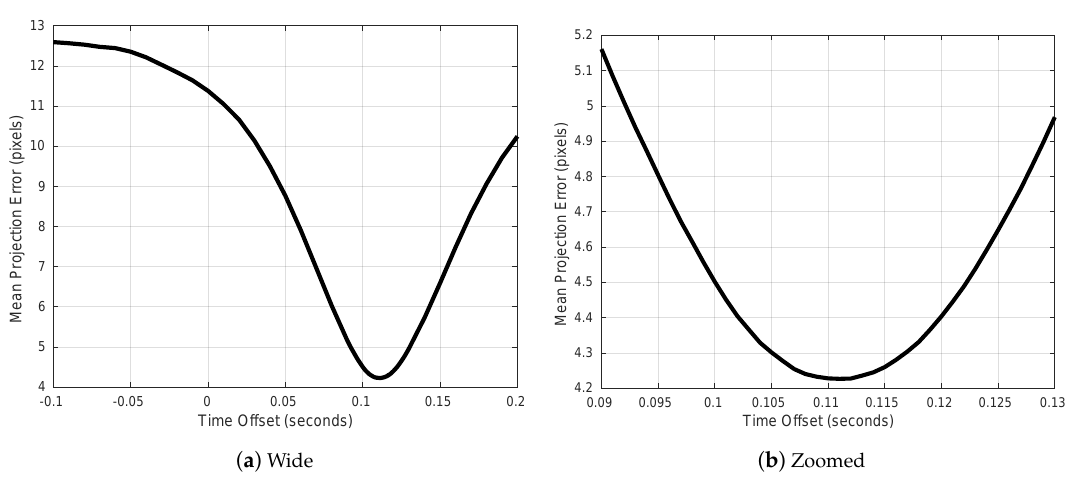
Figure 7. The mean pixel association error for all fruits in the 16 target trees, as a function of an additive time offset between the navigation data from the GPS/INS and the images. A clear global minimum is visible. The peak occurs for a time offset of 0.111 s, with a minimal average error of 4.2 pixels.